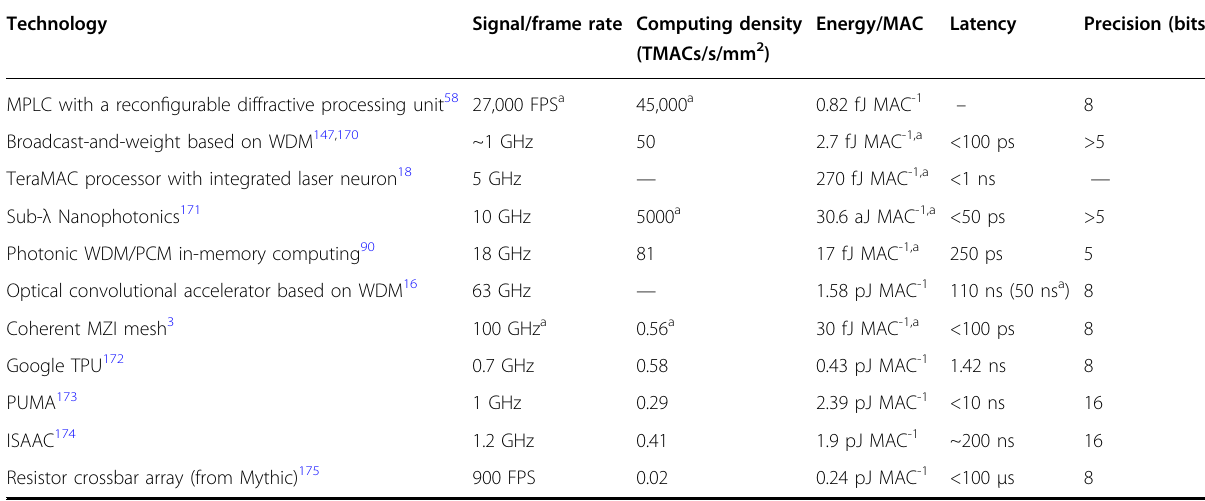
Table 2 Comparison of different recently demonstrated photonic AI accelerators with electronic hardware